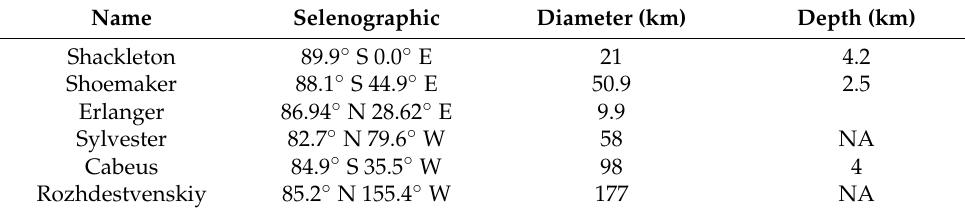
Table 1. Selected LUNAR craters of eternal darkness [65].